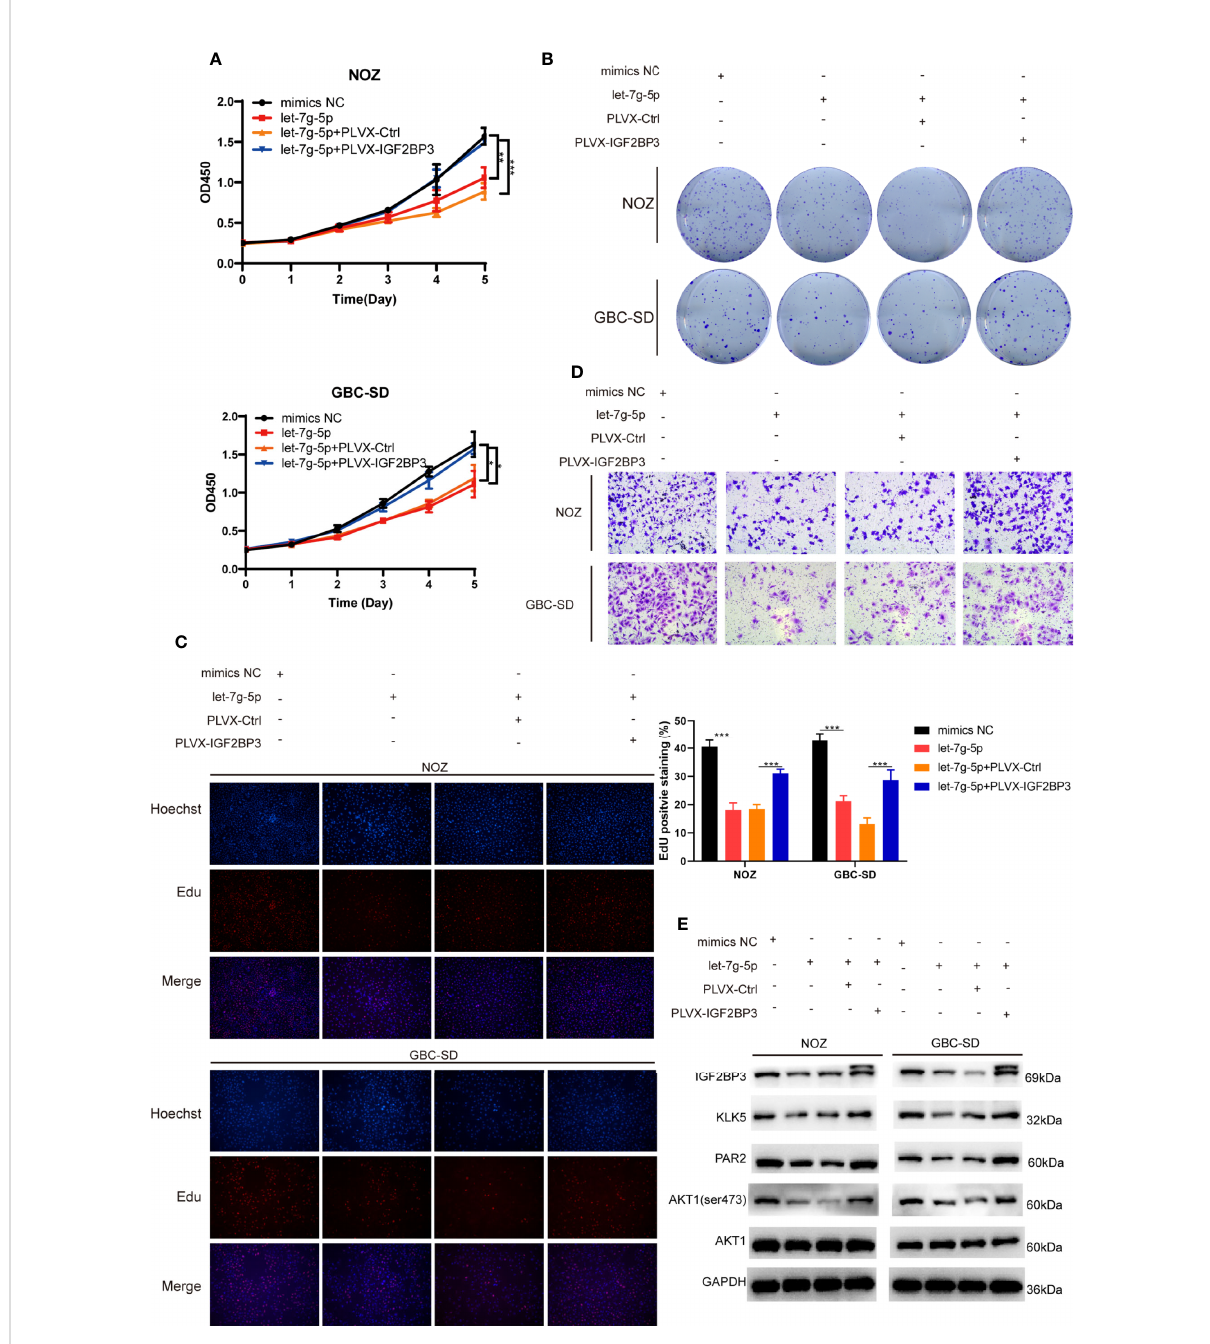
FIGURE 7 let-7g-5p inhibited GBC progression and was rescued by IGF2BP3 (A – E) GBC cells overexpressing let-7g-5p were co-transfected with PLVX- IGF2BP3 or control plasmids. Cell growth capacity was evaluated via CCK8 assay (A) , colony formation assay (B) and EdU assay ( C ,100X, scale bar: 100 m m). EdU stained cells was counted and statistical signi fi cance was analyzed (right). (D) Transwell assays were performed to compare the migration ability in different treatment groups of GBC cells (100X, scale bar: 100 m m). (E) Western blotting assays showed the expression of targets in the downstream pathway in different treatment groups, GAPDH was used as the endogenous control. Unpaired t test was used in (A, C) Data is shown as mean ± SD; * P<0.05. ** P < 0.01. *** P <